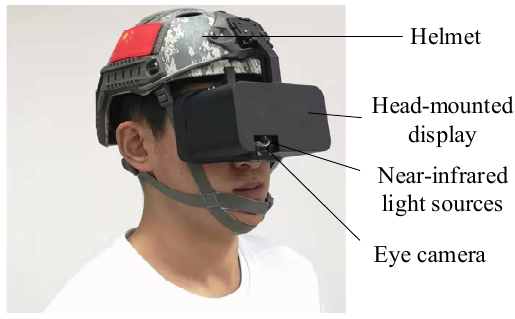
Figure 7. Eye-tracking system device.